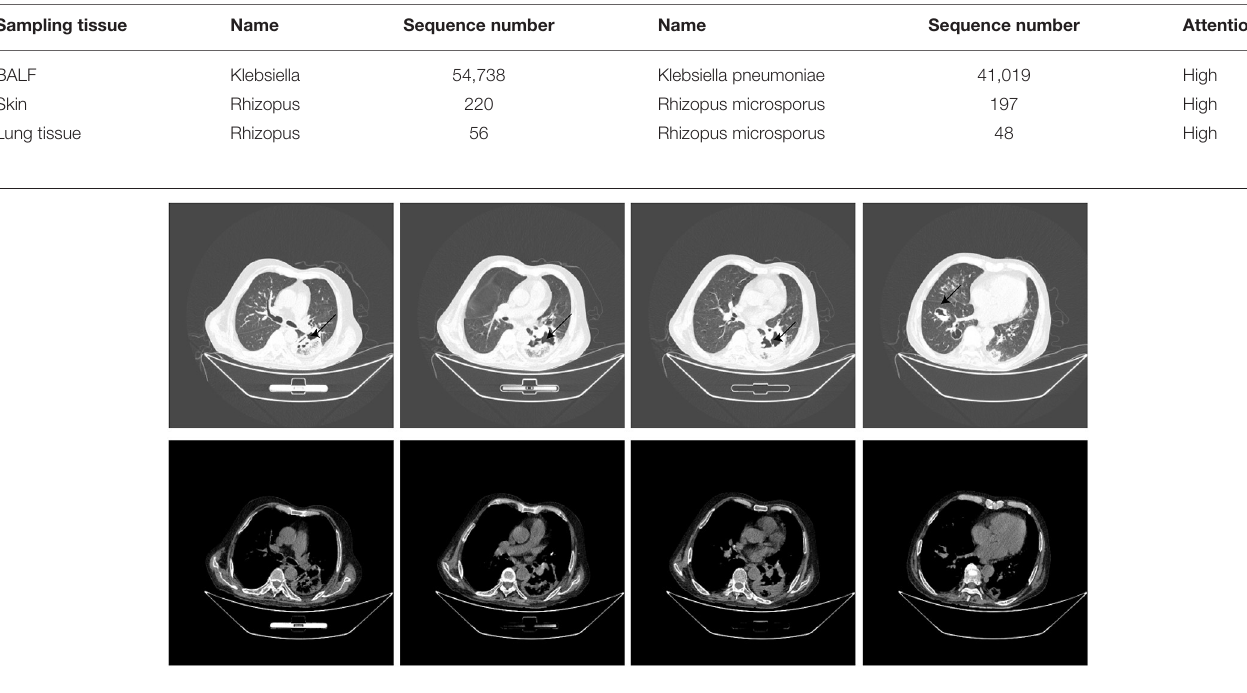
FIGURE 2 | Chest CT 10 days after